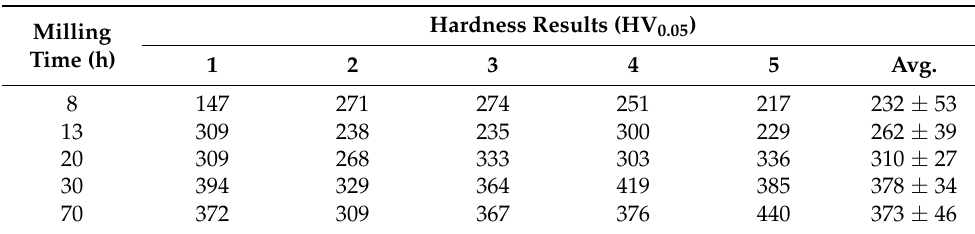
Figure 6. Bending strength values achieved from the three-point bending test for specimens after 13, 20, and 70 h of milling time. Table 4. Microhardness results for Mg-Zn-Ca-Pr alloy powders milled for a varied amount of time. Microhardness results are presented as the mean ± standard deviation